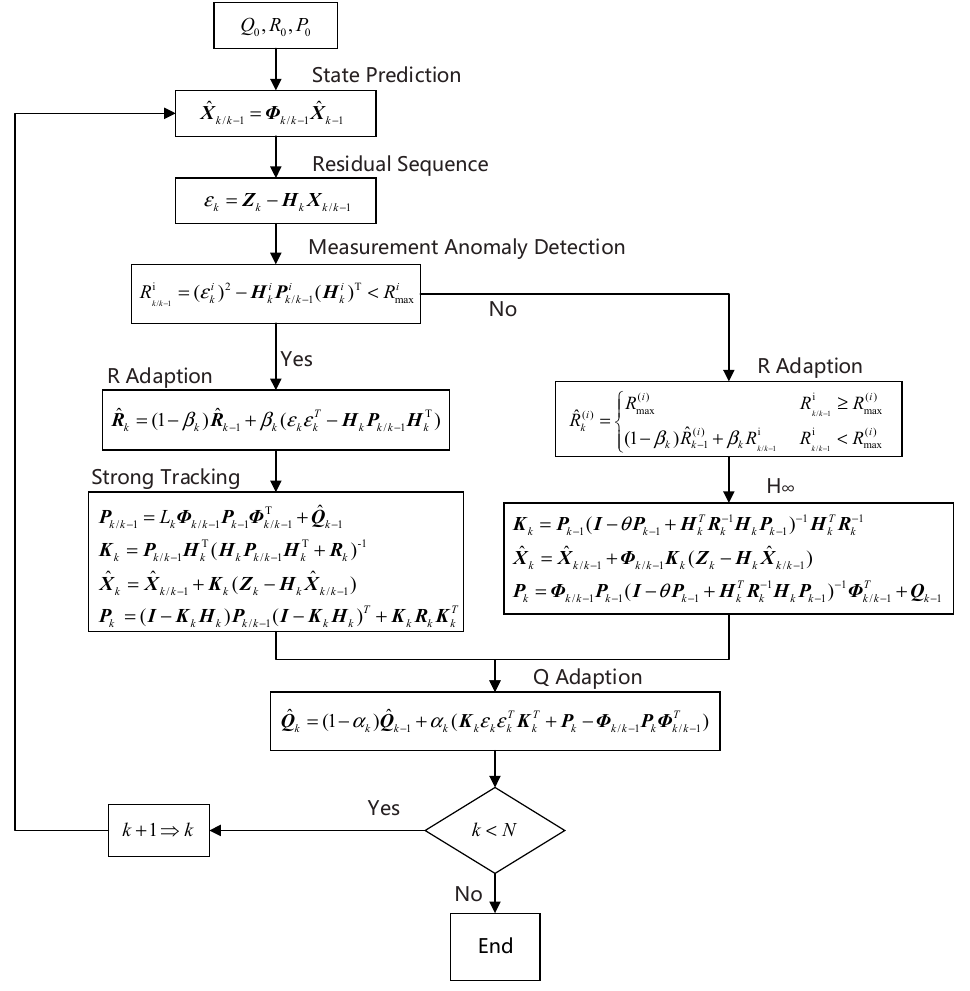
Figure 1. The process of the strong adaptive Kalman filter. The whole flow chart includes state prediction, residual, and measurement anomaly detection, filtering of the main body, and Q Adaption. Part 1. State prediction update equation is given as follows, ˆ X k is the priori state estimation at step k . ˆ X k / k − 1 is the estimation from time step k − 1 to k . Φ k / k − 1 relates the state at time step k to